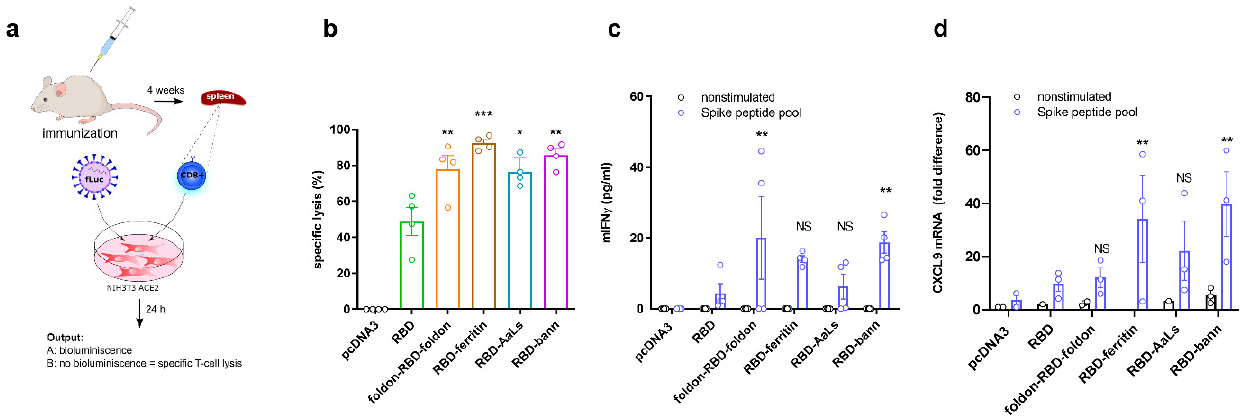
Figure 4. Spike protein-specific cytotoxic killing by lymphocytes from immunized animals. Cytotoxic T-cell killing from immunized mice against cells expressing viral S protein. Mice were immunized with different combinations of RBD plasmid DNA, and mice spleens were harvested after four weeks. The cytotoxic effect of isolated CD8 + T cells was determined on pseudovirus-infected hACE2 and TMPRRS-transfected NIH-3T3. Bioluminescence was determined 24 h post co-culture of murine spleen cells with NIH-3T3 cells ( a ). Based on radiance values obtained from pseudovirus infection, specific lysis of NIH-3T3 cells was calculated ( b ). Mouse splenocytes from DNA-immunized animals were stimulated with a spike peptide pool, IFN γ was measured 24 h post-stimulation ( c ), and CxCl9 mRNA fold expression was determined ( d ). Each dot represents spleen cells from an individual animal ( n = 4). * p < 0.05, ** p < 0.01, *** p < 0.001. All p values are from one-way ANOVA followed by Tukey’s multiple comparisons test.